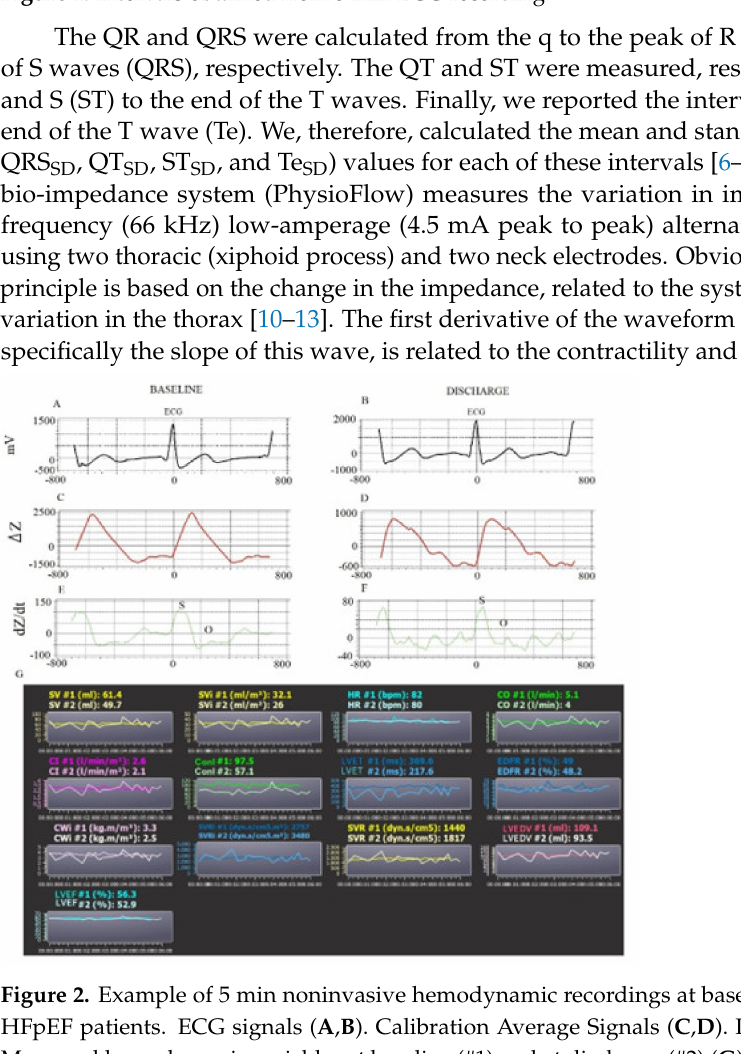
Figure 1. Intervals obtained from 5 min ECG recording.